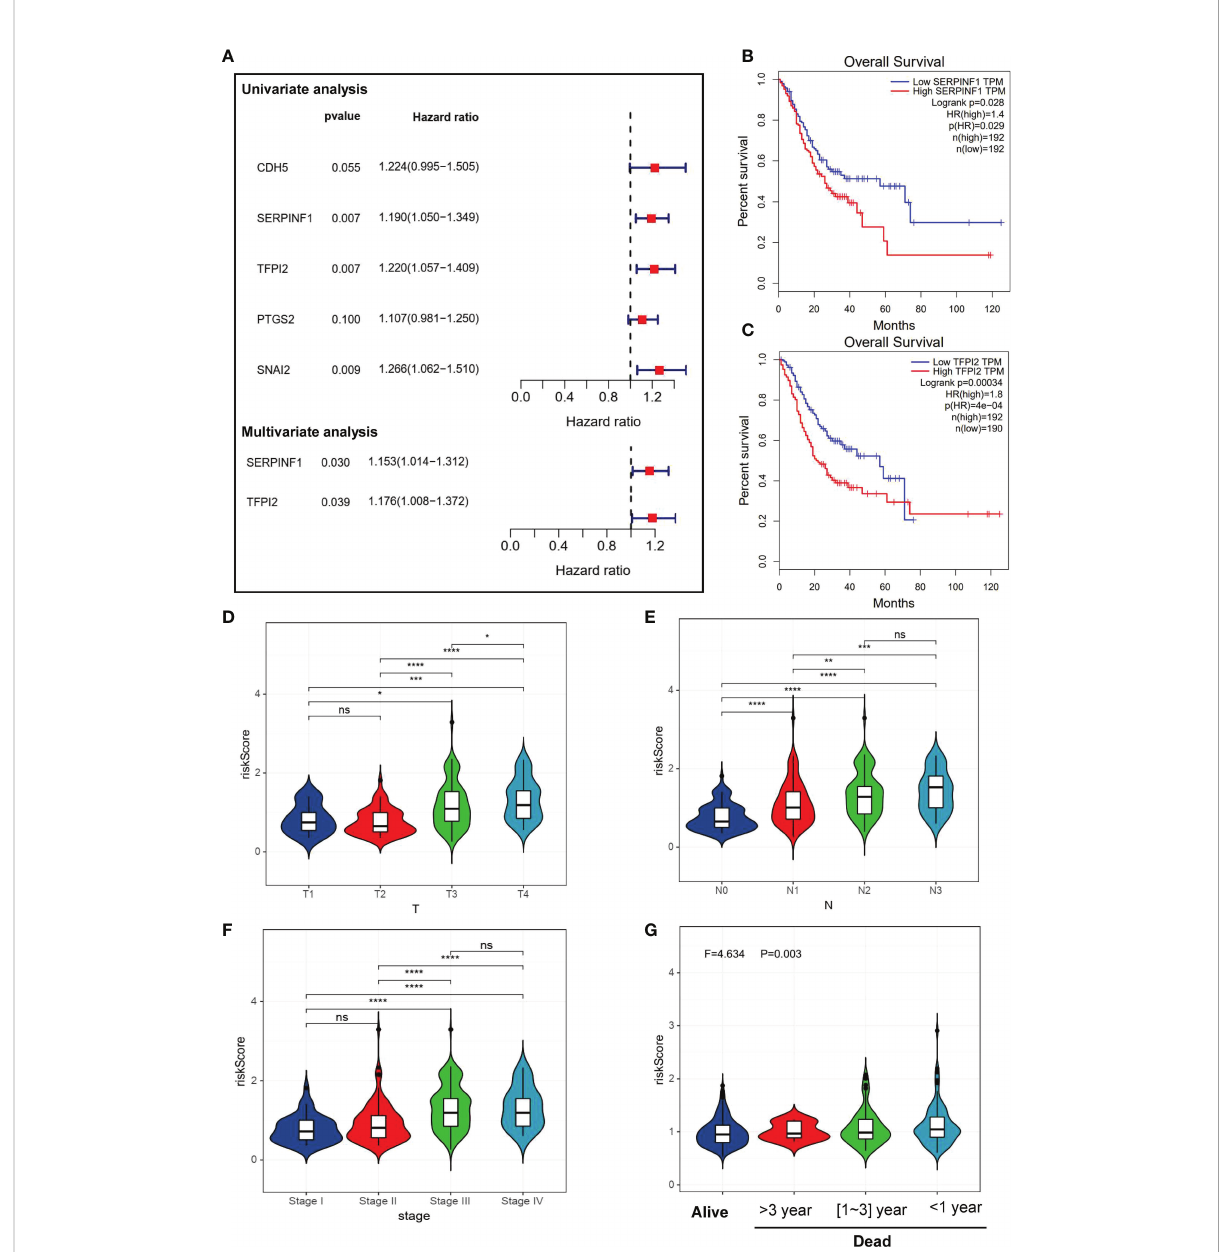
FIGURE 2 Identi fi cation of VM-related genes in GC. (A) A forest map of the most important VM-related genes found by Univariate and Multivariate Cox regression analysis in GC. (B, C) Kaplan-Meier survival analysis showed that high expression level of SERPINF1 and TPFI2 were correlate to worse overall survival. (D – G) Violin plots of VM-index with clinical factors. (D) stage of GC. (G) VM-index with survival status in GC. VM-index with T stage of tumor. (E) VM-index with N stage of tumor. (F) VM-index with tumor stage. (G) VM-index with survival status. * means P < 0.05, ** means P < 0.01, *** means P < 0.001, **** means P<0.0001. ns indicates not signi fi cant